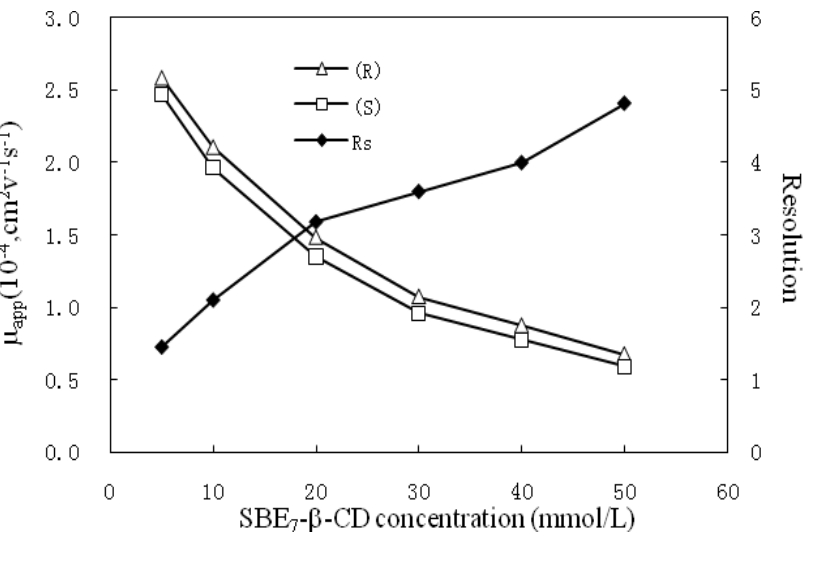
- β -CD concentration on resolution. Separation condition: Figure 4. The effect of SBE 7 20 mmol/L phosphate buffer at pH 7.5 containing 20% methanol; the other conditions are same as in Figure